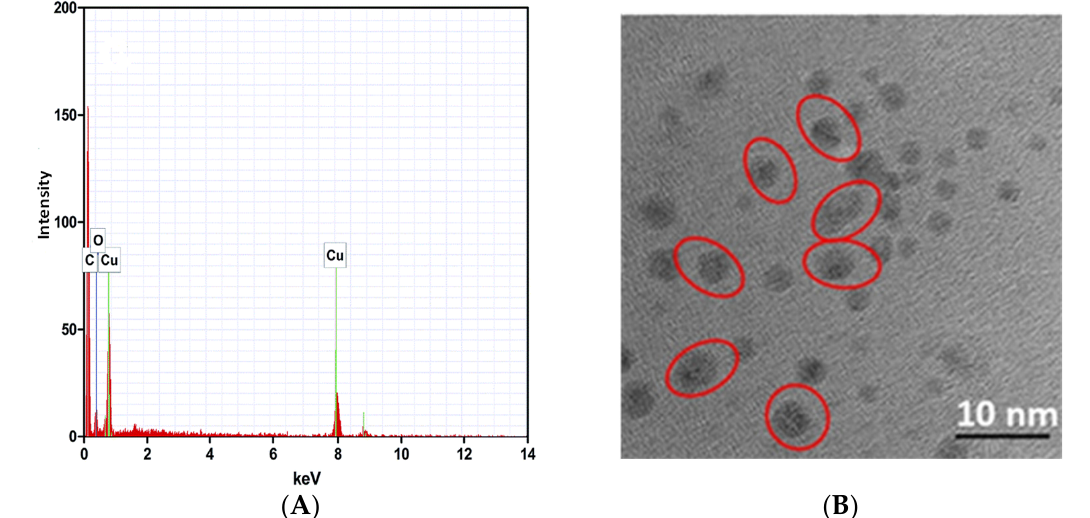
Figure 5. ( A ) EDX spectra of the CuNPs/MIP-OPPy composite. ( B ) HR-TEM image of the CuNPs on the composite surface.